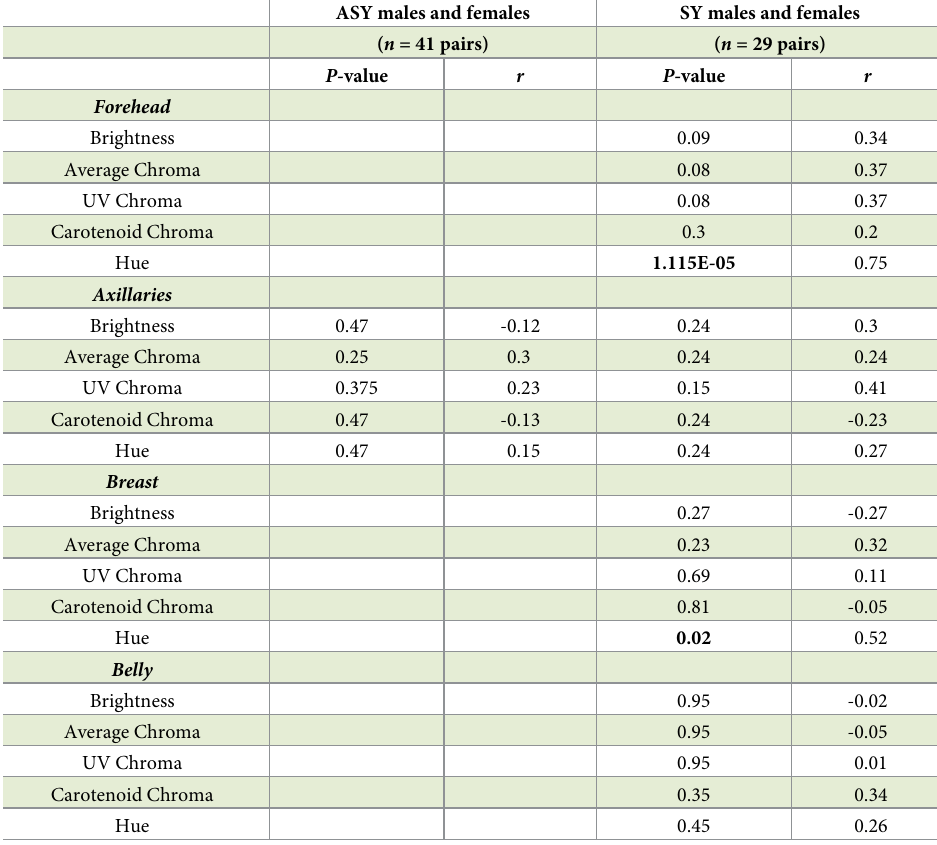
Table 3. Correlations of color variables in pairs formed by after second-year and second-year males. Pearson product-moment correlations; significant results are shown in bold. P -values were corrected for multiple comparisons using Benjamini and Hochberg method for False Discovery